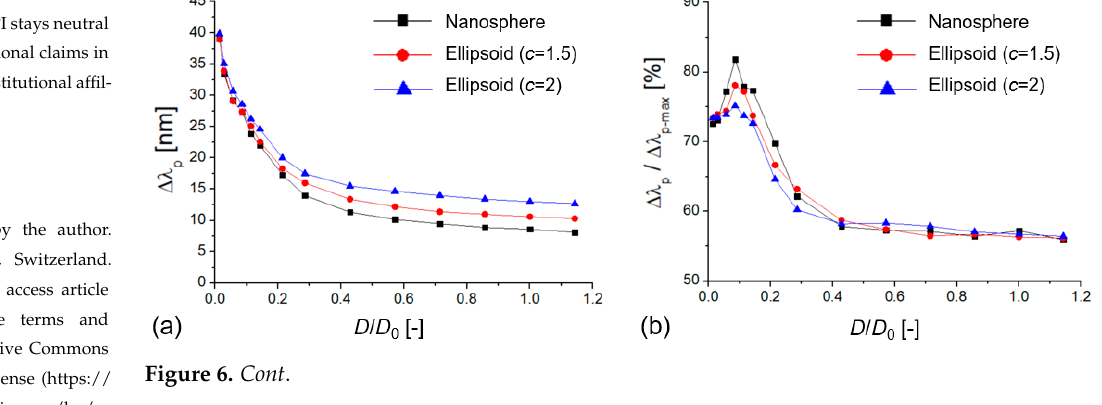
Figure 6. ( a ) Extinction peak shift ( ∆𝜆 (cid:3043) ) of different dimer arrangements as a function of the dimen- sionless D / D 0 value ( D 0 = 70 nm) with a dielectric layer of 5 nm ( n l = 1.5 in water medium, with n = 1.33). ( b ) Relative extinction peak shift as a function of the dimensionless D / D 0 value, where ∆𝜆 (cid:3043)(cid:2879)(cid:3040)(cid:3028)(cid:3051) is calculated as the peak shift upon the RI of the medium changing from 1.33 to 1.5. ( c ) Enhancement factor ( EF t=5nm ) as a function of D / D 0 . ( d ) Difference between surface and bulk en- hancement factors ( EF t=5nm -EF ∞ ) as a function of D / D 0 . 2. Text Correction There were two textual errors in the original publication. On page 4, in one instance, RIS dim was written instead of ∆𝜆 (cid:3043),(cid:3031)(cid:3036)(cid:3040) . A correction has been made to “3. Results and Discussion”, first paragraph: “By depositing a dielectric layer of 5 nm thickness and n l = 1.5, the experienced ex- tinction peak shifts were ∆𝜆 (cid:3043),(cid:3046)(cid:3043) = 6.1 nm and ∆𝜆 (cid:3043),(cid:3031)(cid:3036)(cid:3040) = 18.2 nm (Figure 2b), correspond- ing to an enhancement of 2.98 ( EF t=5nm ).” On page 5, in one instance, t = 7 nm was written instead of t = 5 nm. A correction has been made to “3. Results and Discussion”, seventh paragraph: “The practical meaning of EF t is, for example, that dimer nanospheres of 70 nm di- ameter and 10 nm gap provide a 3.2 times higher signal compared to uncoupled spheres of the same size with t = 5 nm layer thickness.” The author apologizes for any inconvenience caused and states that the scientific con- clusions are unaffected. The original publication has also been updated. Reference 1.